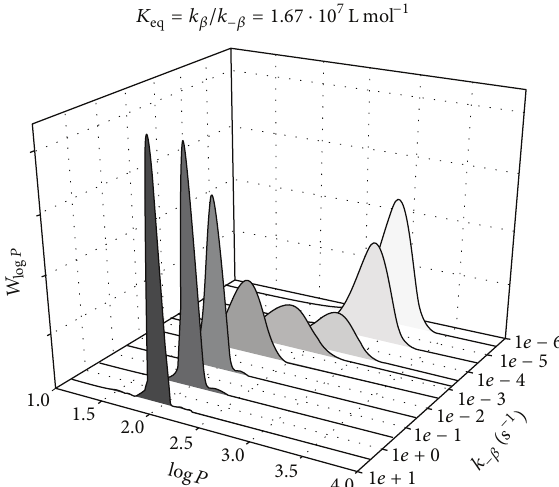
Figure 4: Simulated full MWD by changing the values of 𝑘 𝛽 and 𝑘 −𝛽 . All rate constants and reaction data are available in